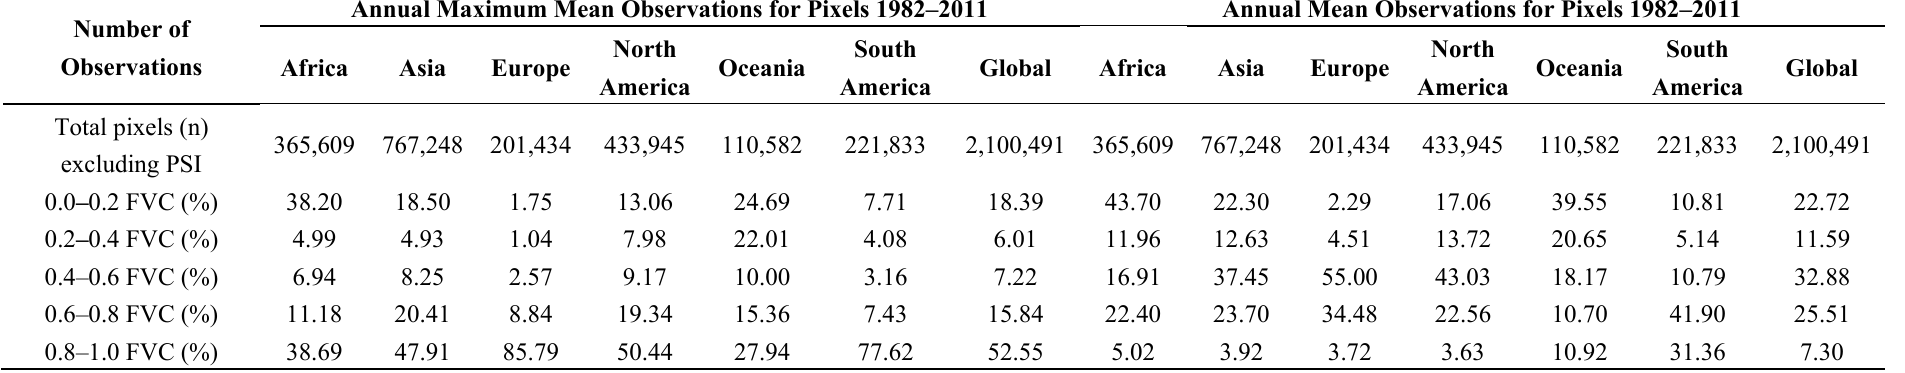
Table 2. Results for the average of the GIMMS FVC with limited or no vegetation growth are masked (PSI, permanent snow and ice).